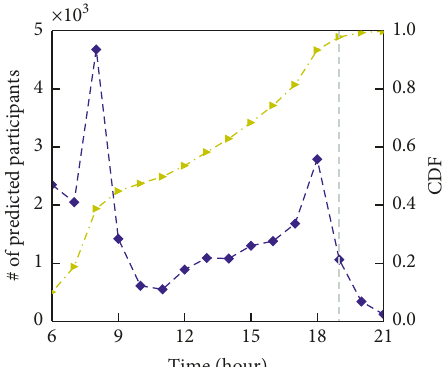
Figure 6: The number of predicted event participants and the cumulative distribution function (CDF) of predicted event par- ticipants over time based on the proposed nfc -gram model. A large fraction of event participants can be predicted several hours before the crowding event (the dotted